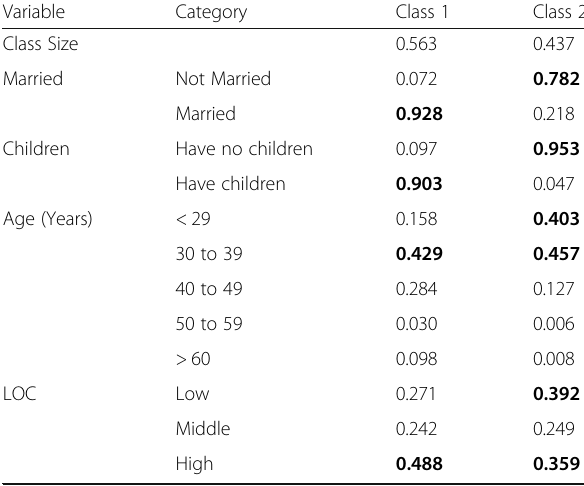
Table 3 Composition ratio of each latent class and the conditional response probability in the 2-class